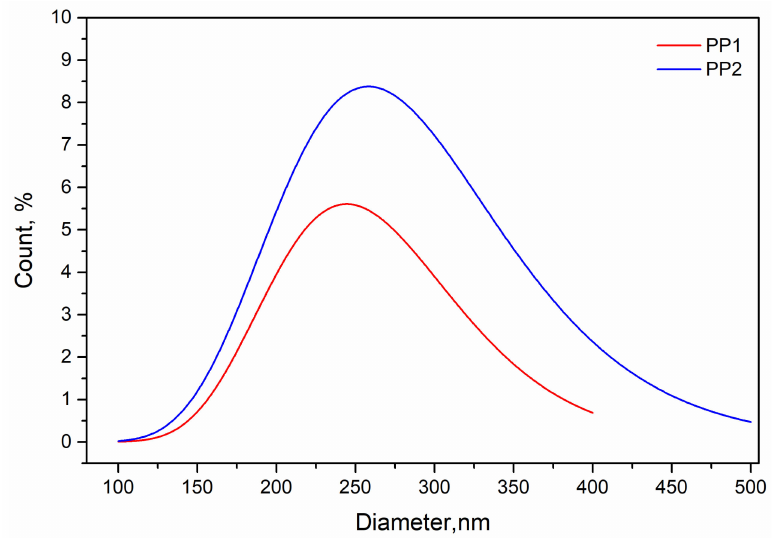
Figure 8. Distribution of the equivalent diameters of the two polypropylene